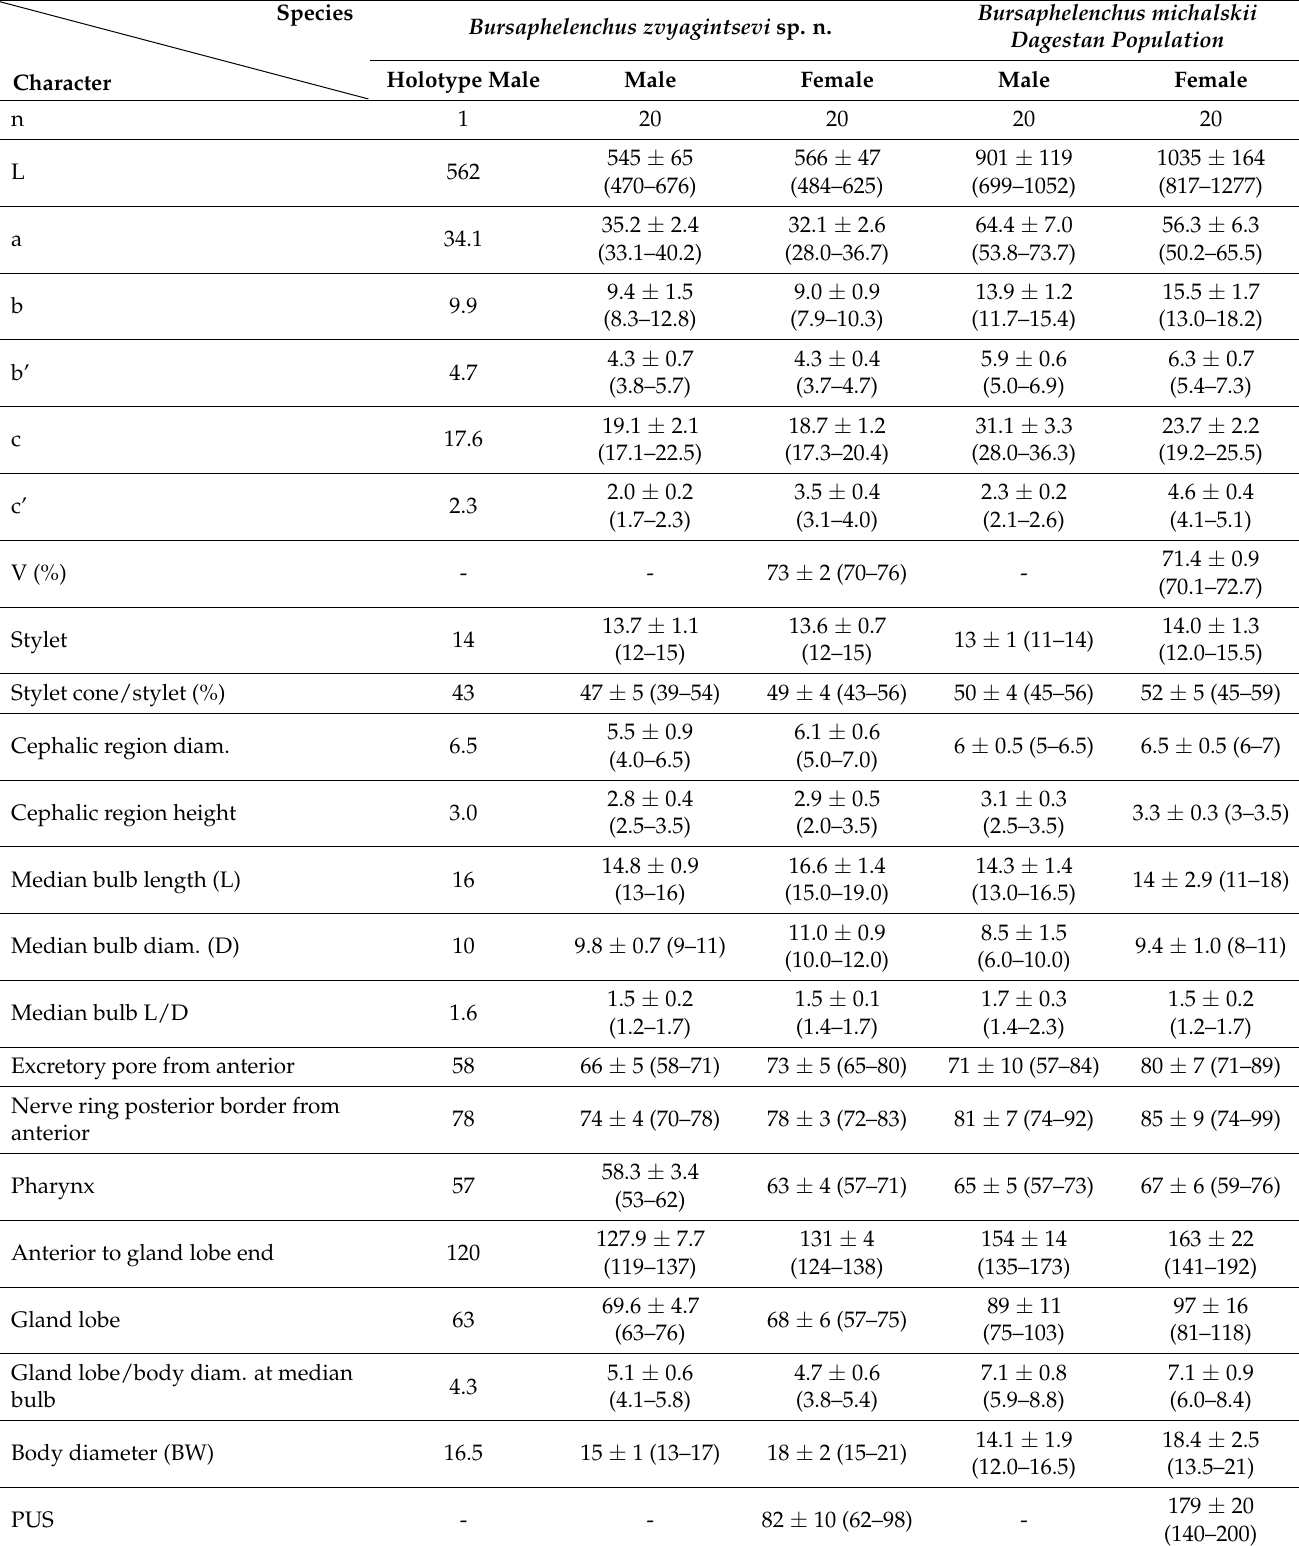
Table 2. Measurements (in µ m) and indices of Bursaphelenchus zvyagintsevi sp. n and B. michalskii . All measurements are in µ m and in the form: mean ± s.d.